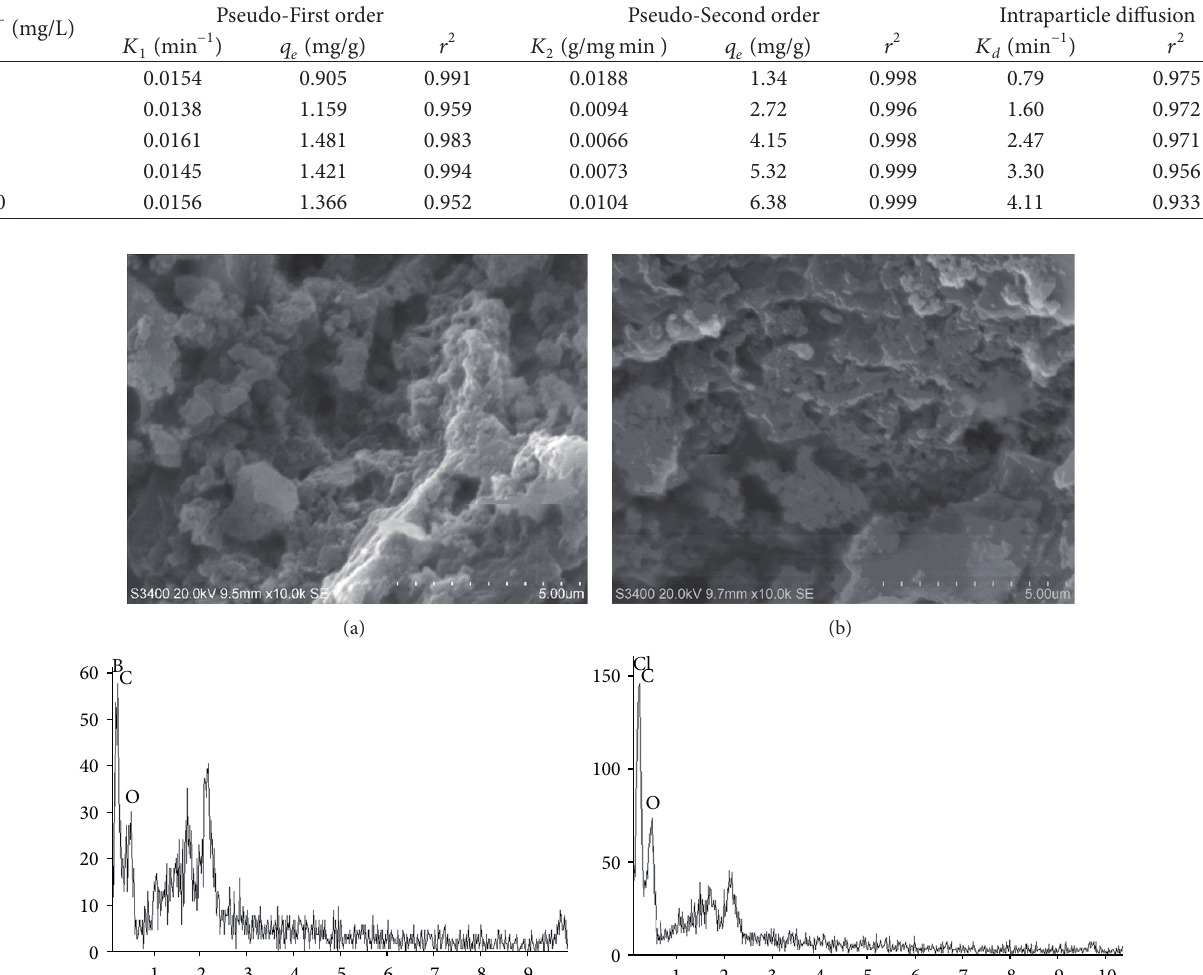
T 4: Kinetic parameters of values of ZIWSC.